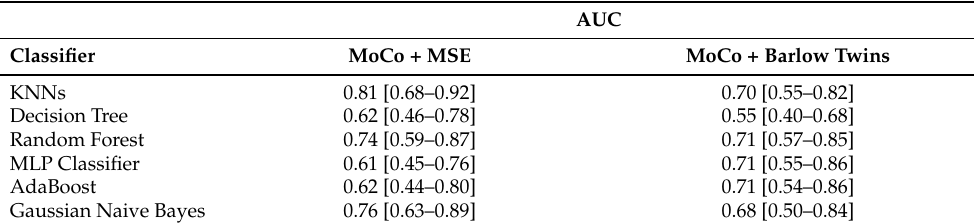
Table 5. Performance of models trained via self-supervised learning methods (MoCo + MSE and MoCo + BT) for the stroke vs. control classification task after fine-tuning on different classifiers. Full cohort is used.